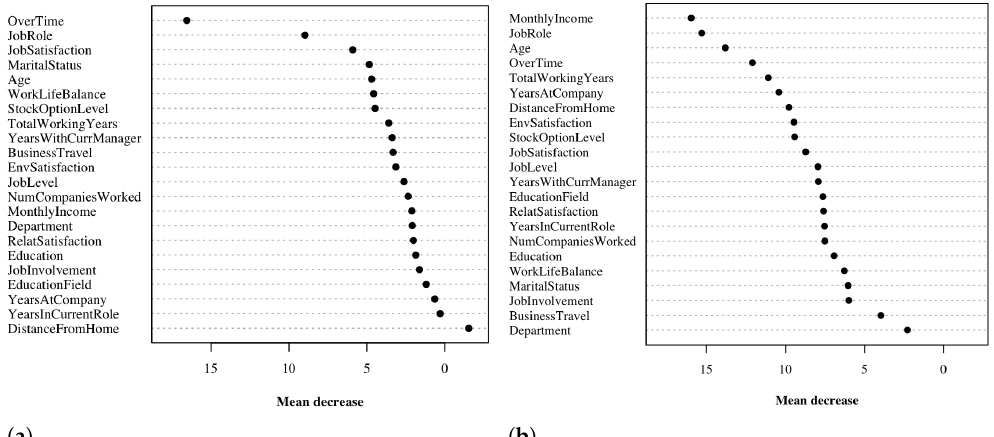
Figure 5. Variable importance by mean decrease in accuracy and Gini index for the Random Forest Model. The variables with higher values of mean decrease are the ones that impact the most the performance of the Random Forest model. Both the mean decrease in accuracy and the mean decrease in the Gini index are shown with a cutoff of 0.5. ( a ) Mean decrease in accuracy. ( b ) Mean decrease in Gini index. Table 2. Performance of the models on the dataset [9]. Results reported as mean and standard deviation on 5-fold cross validation. Best in bold